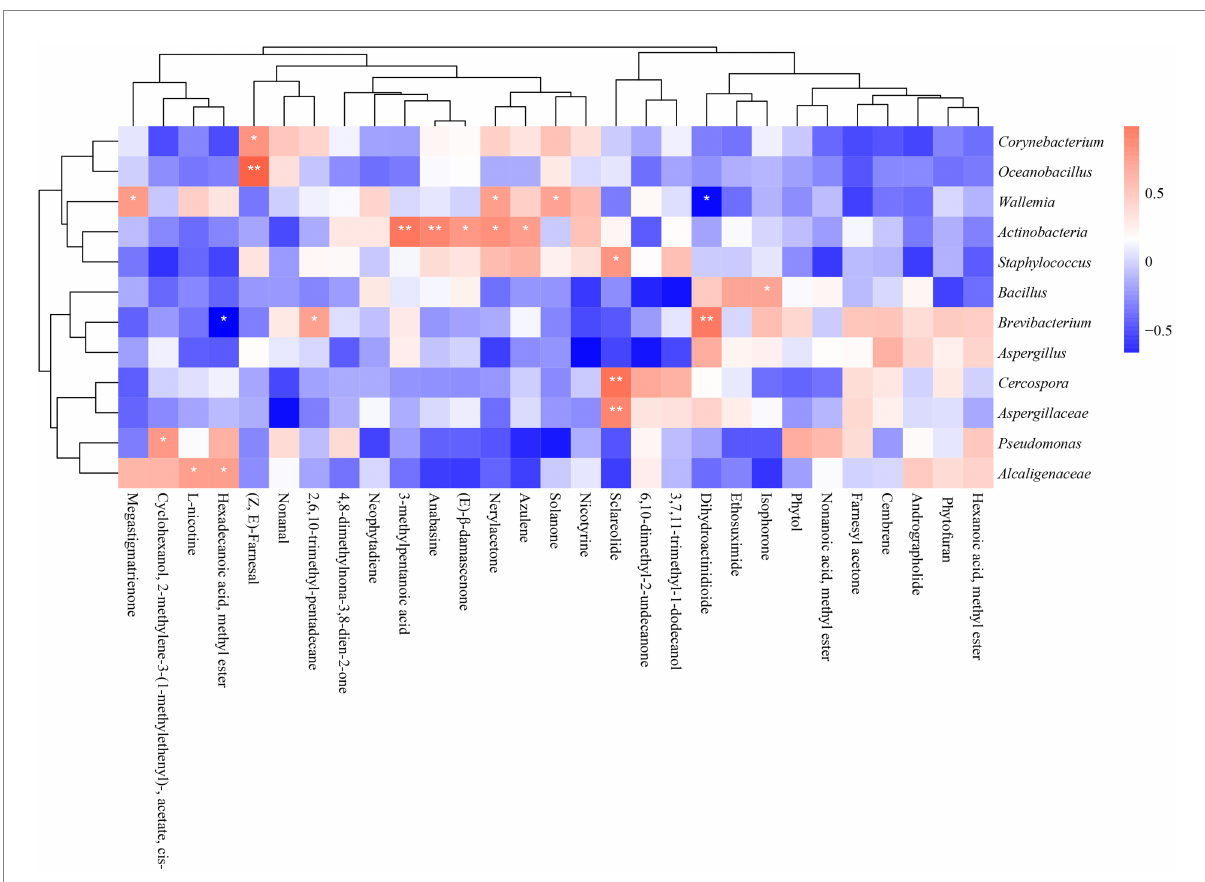
FIGURE 9 Heatmap of the correlation between dominant microorganisms and volatile metabolites in different continents (* p < 0.05, ** p < 0.01). Blue represents negative correlation, red represents positive